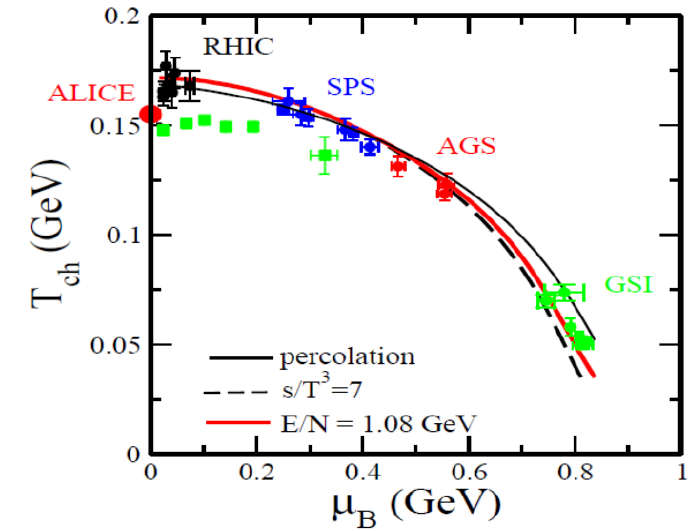
Figure 1. Freeze-out curve in the statistical hadronization model compared with the criteria discussed in the text. The green squares without error bars are the QCD lattice simulation data.